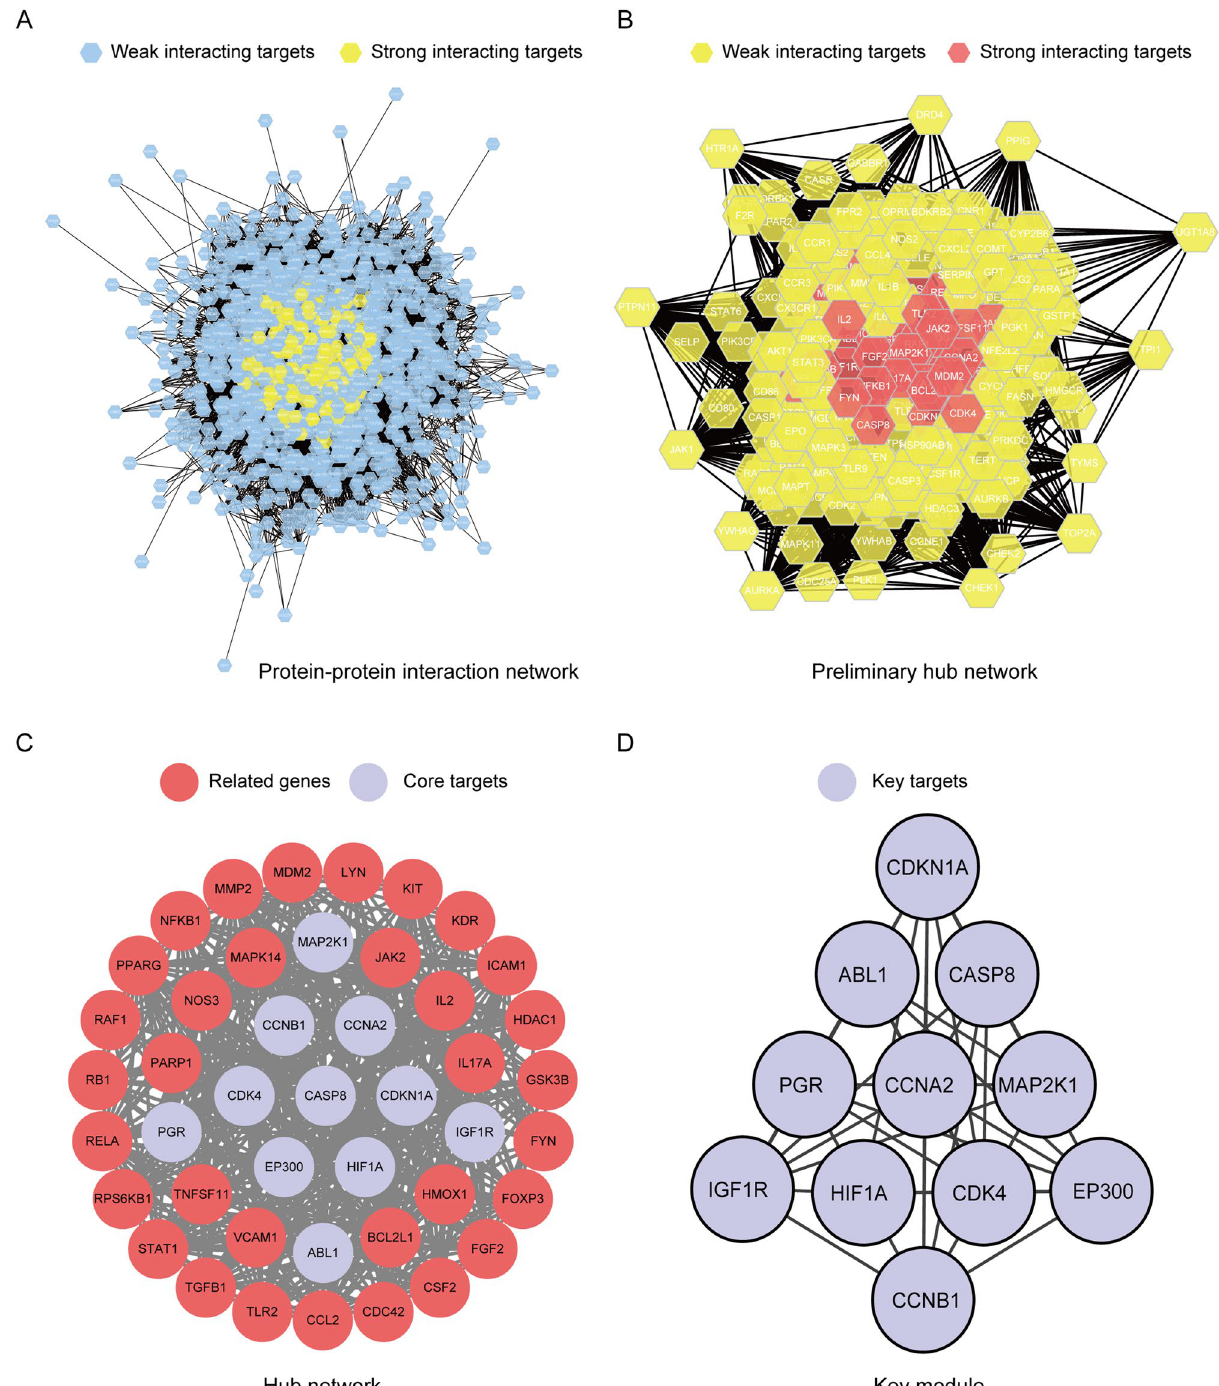
Figure 3. Identification of the key target genes through modules analysis. ( A ) Protein-protein interaction network. Blue hexagons represent weak interacting target genes, yellow hexagons represent strong interacting target genes; ( B ) Preliminary hub network. Yellow hexagons represent weak interacting target genes, red hexagons represent strong interacting target genes; ( C ) Hub network. Red circles represent related target genes, purple circles represent core target genes; ( D ) Key module. Purple circles represent key target genes. [Fig. 3 was drawn by Cytoscape 3.8.0 (https:// www. cytos cape.